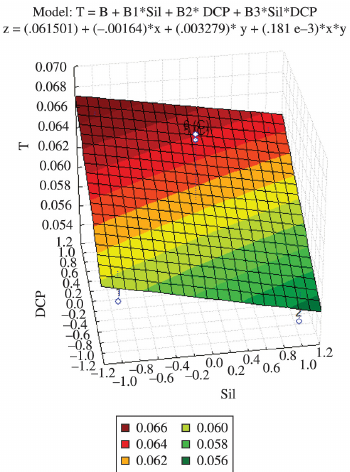
Figure 8. Chart of composites with silica surface in the experimental design for Tan delta